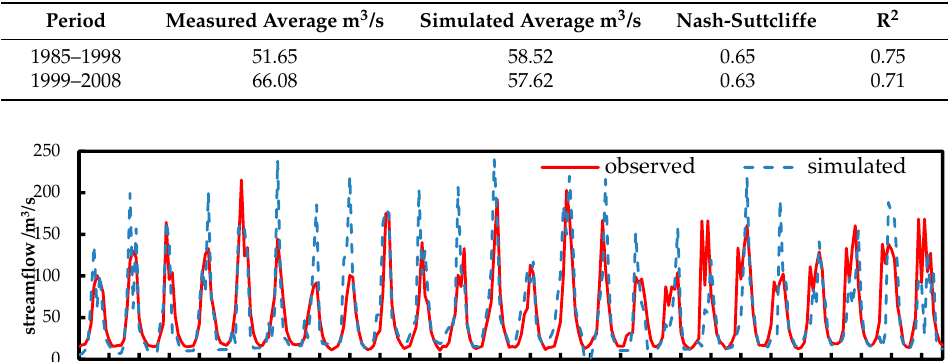
Table 6. Calibration and validation results of SWAT model for monthly streamflow.